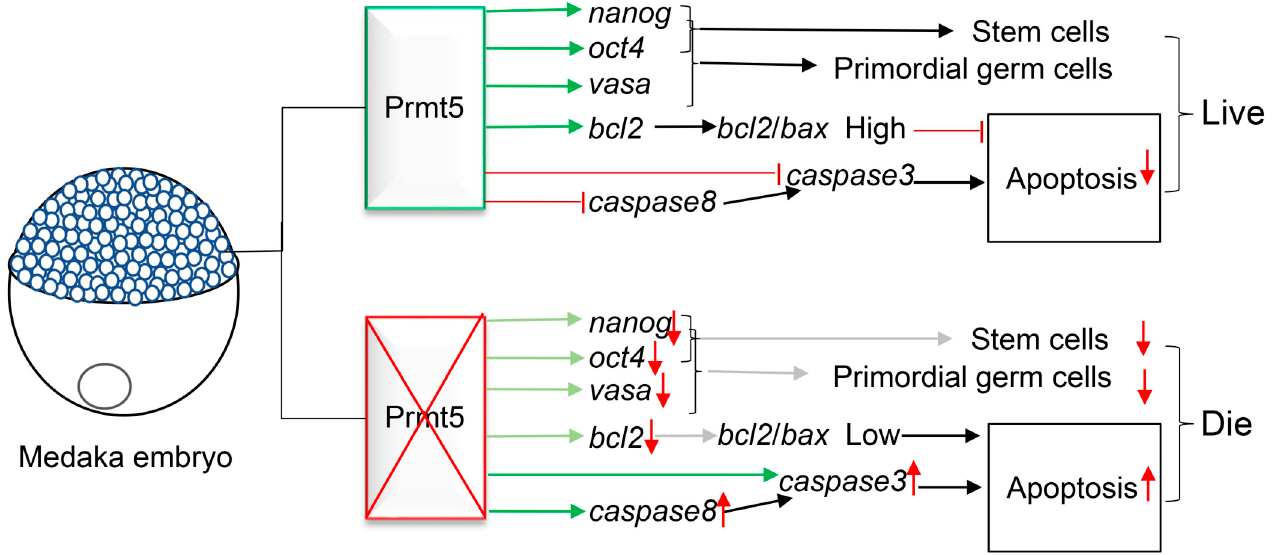
Figure 6. A diagram indicating the functions of Prmt5 in medaka embryos. In the wild type, Prmt5 is functional (in green frame) to maintain the nanog , oct4 , and vasa expression in the stem and primordial germ cells. Prmt5 promotes the expression of bcl2, which results in a high bcl2 / bax ratio and represses the expression of caspase8 and caspase3 to prevent apoptosis. So, the embryos of the wild type are live. The contrary events occurred in the homozygotes of the prmt5 mutant (in red frame) and the homozygous mutant embryos